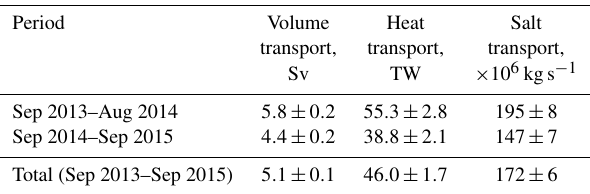
Table 3. Net heat, salt, and volume transports across the 125 ◦ E section in the upper 780m layer in